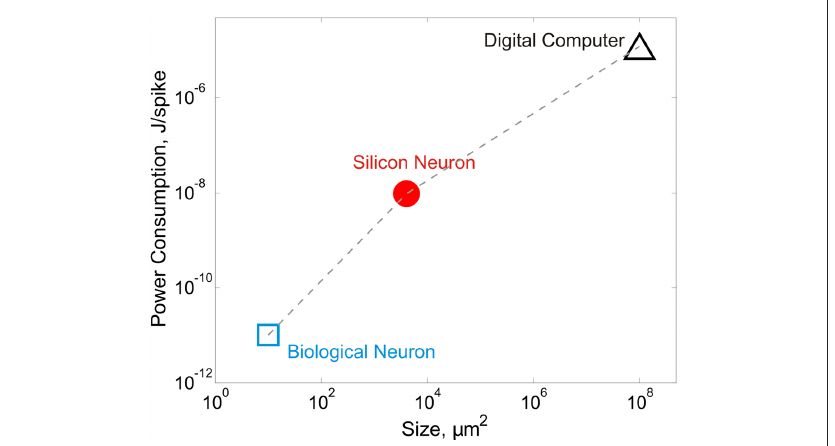
Figure 1 | Biological and silicon neurons have much better power and space efficiencies than digital computers. A biological neuron consumes approximately 3.84 × 10 8 ATP molecules in generating a spike (Attwell and Laughlin, 2001; Lennie, 2003). Assuming 30–45 kJ released per mole of ATP (Berg et al., 2007; or 5–7.5 × 10 − 20 J per ATP molecule), the energy cost of a neuronal spike is in the order of 10 − 11 J. The density of neurons under cortical surface in various mammalian species is ∼ 100,000/mm 2 (Braitenberg and Schüz, 1998), which translates to a span of ∼ 10 μm 2 per neuron. Silicon neurons have power consumption in the order of 10 − 8 J/spike on a biological timescale. For example, an Integrate-and-Fire neuron circuit consumes 3–15 nJ at 100 Hz (Indiveri, 2003) and a compact neuron model consumes 8.5–9.0 pJ at ∼ 1 MHz (Wijekoon and Dudek, 2008), which translates to 85–90 nJ at 100 Hz. For silicon neurons, the on-chip neuron area is estimated to be ∼ 4,000 μm 2 (70 μm × 40 μm in Wijekoon and Dudek, 2008, ∼ 3750 μm 2 in Vogelstein et al., 2007, and 70 μm × 70 μm in Wijekoon and Dudek, 2009). According to Liu and Delbrück (2007), digital computers are 10 4 –10 8 less efficient than biological neurons. The power efficiency of digital computers is therefore estimated to be 10 − 3 –10 − 7 J/spike. Most current multi-core digital microprocessor chips have dimensions from 263 to 692 mm 2 . A single core has an average size from ∼ 50 to ∼ 90 mm 2